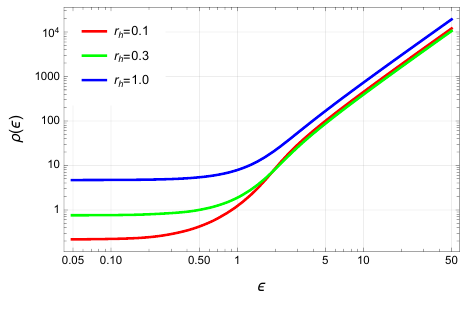
Figure 8 . ρ ( (cid:15) ) for r h = 0 . 1 , 0 . 3 , 1 . 0 . Figure 9 . The condensation of Ψ (2) with respect to the Hawking temperature T ( r h ) , where ρ is set to be